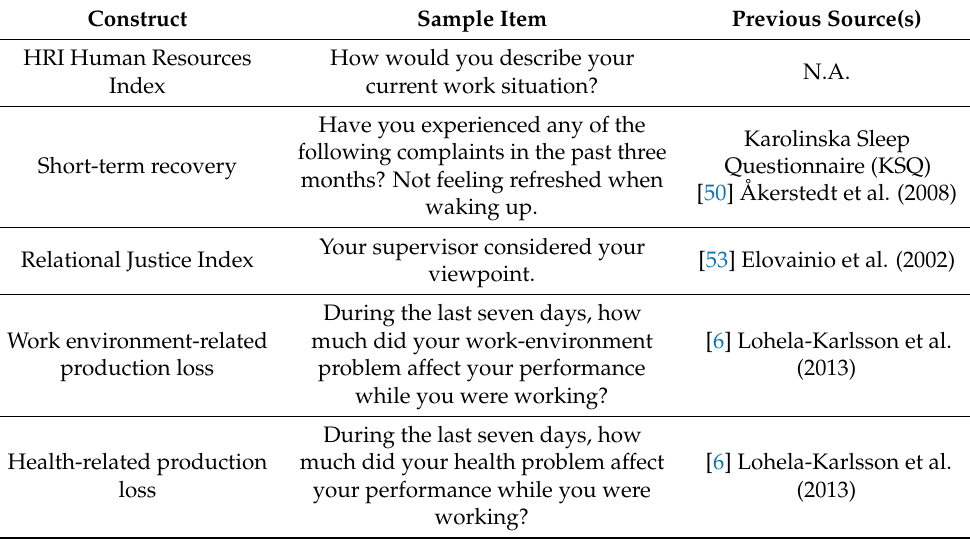
Table 1. Sample survey